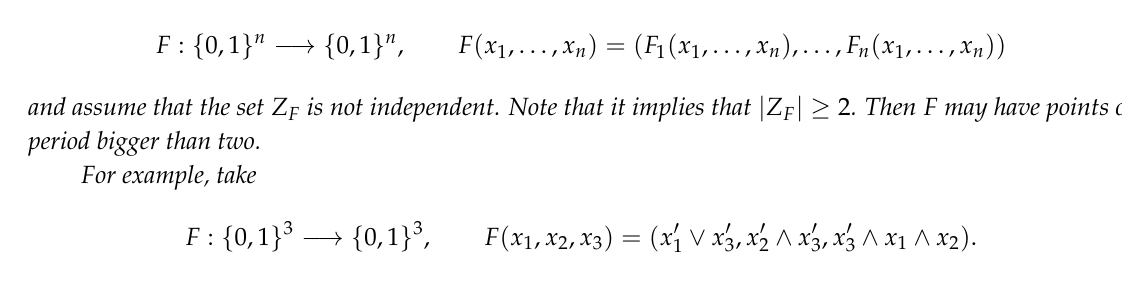
(cid:48) ∧ x ∨ x (cid:48) , x 1 ∨ x 3 ) 3 , x 2 3 1